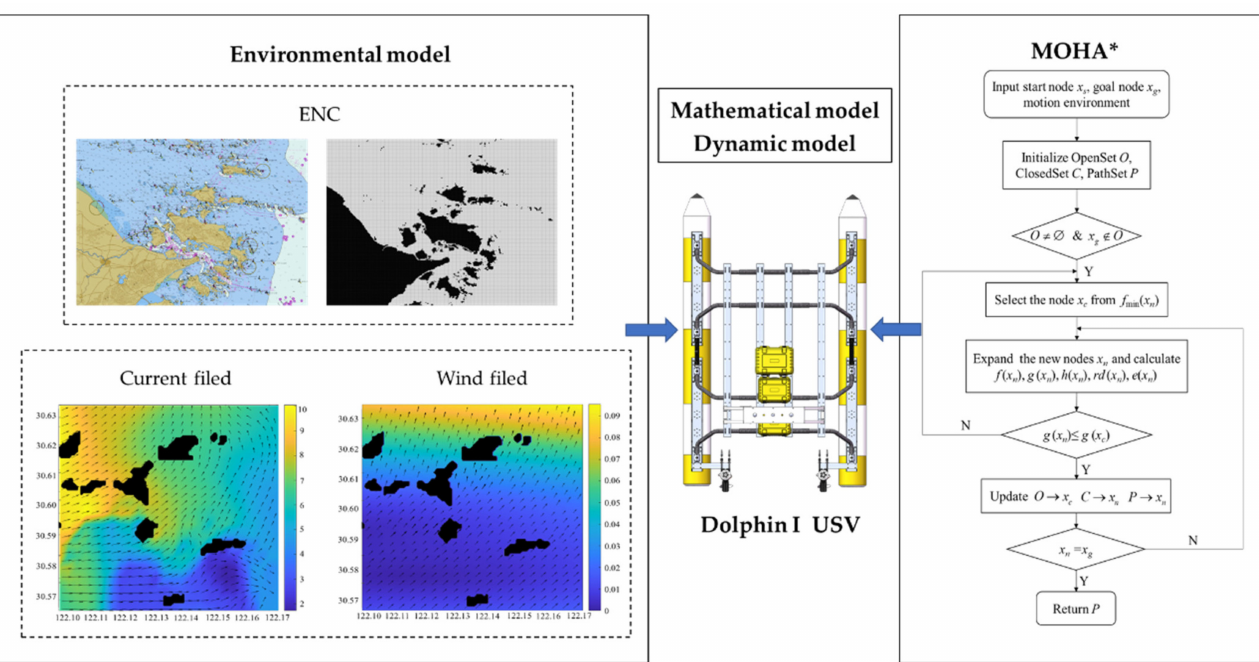
Figure 2. Full text structure